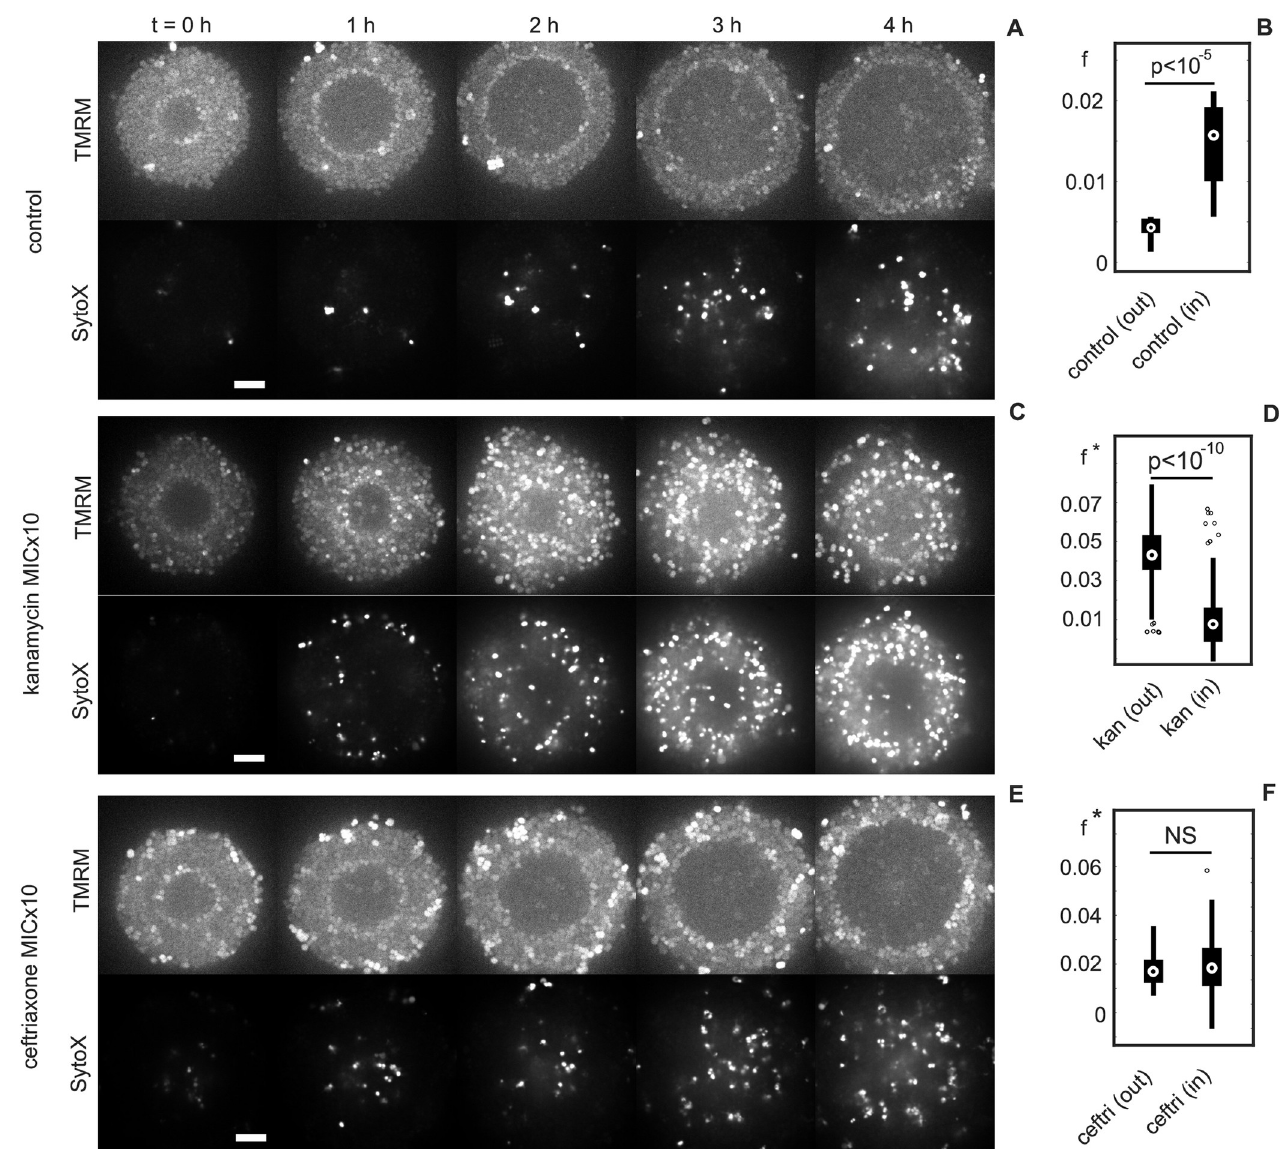
Fig 5. Dynamics of membrane potential and fraction of dead cells F in colonies after 30 min of antibiotic treatment. Strain wt � (NG150), flow chamber. (A, C, E) Time lapse over 4 h of TMRM and SytoX fluorescence after respectively: no treatment, kanamycin treatment (MICx10, 200 μg / ml ), and ceftriaxone treatment (MICx10, 0.04 μg / ml ). Scale bar: 5 μ m. (B, D, F) Fraction of dead cells f in the colonies 3–4 h later for both the region unaffected by the hyperpolarization shell (out) and the region affected (in) after respectively no treatment, kanamycin treatment, and ceftriaxone treatment. In the treated cases, f � = f − < f control > . A total of 60 colonies evaluated for each condition. Bottom and top edges of the box indicate the 25th and 75th percentiles, respectively. Whiskers extend to the most extreme data points not considered outliers (marked as individual points). Central mark indicates the median of the distribution (see S1 Data for raw